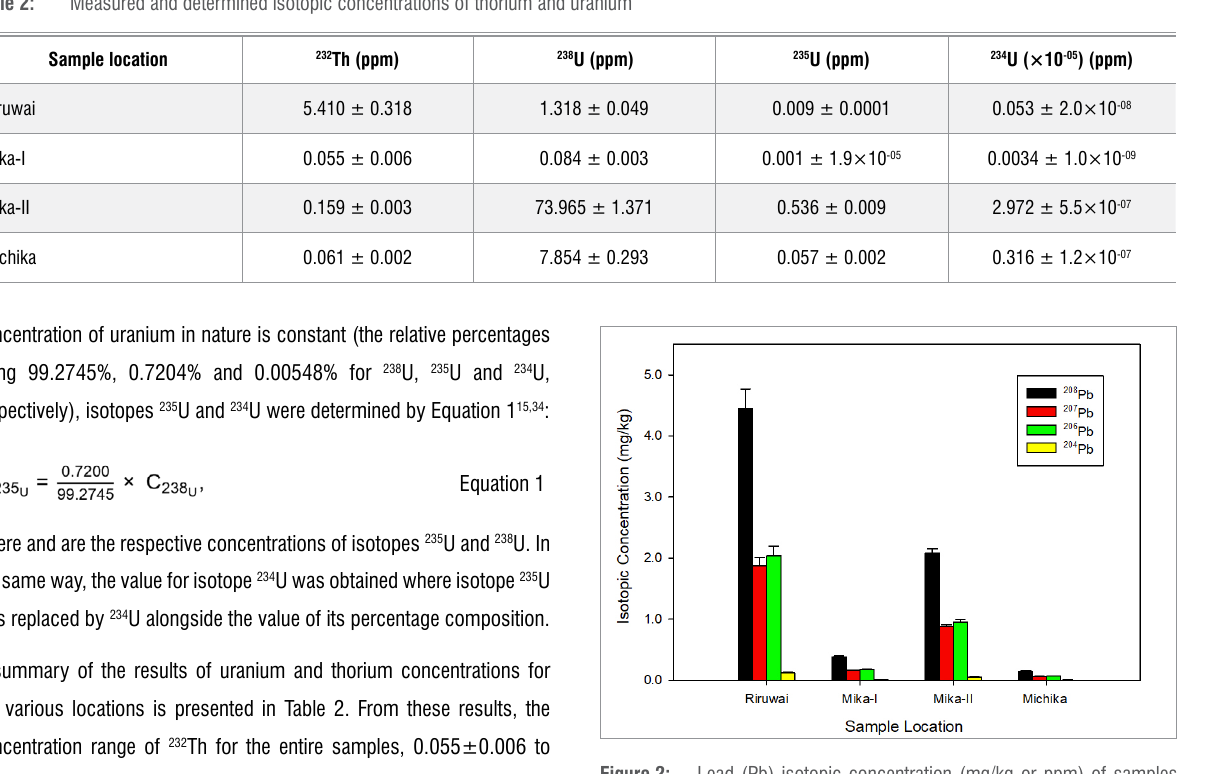
Figure 2: Lead (Pb) isotopic concentration (mg/kg or ppm) of samples obtained from the four study